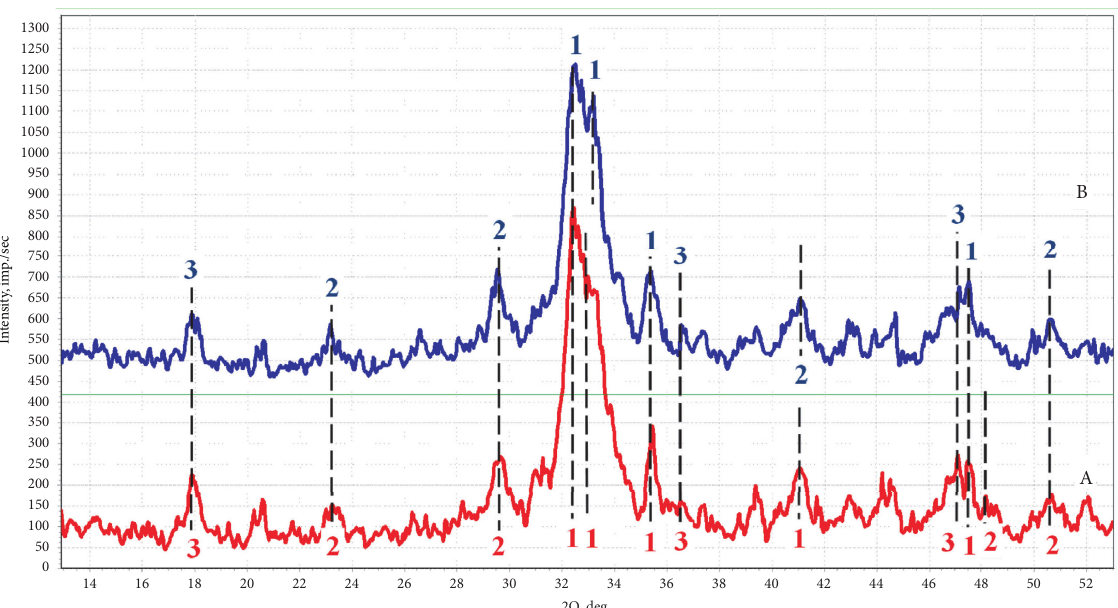
Figure 13: Diffraction patterns of cement paste (A) and cement paste in a composite based on a modified shot of titanium hydride (B), subjected to c -irradiation dose D � 5MGy: 1-Ca 2 SiO 4 · 0, 3 O 2 P ; 2-Ca 2 SiO 4 ; 3-Ca(OH) 2 .